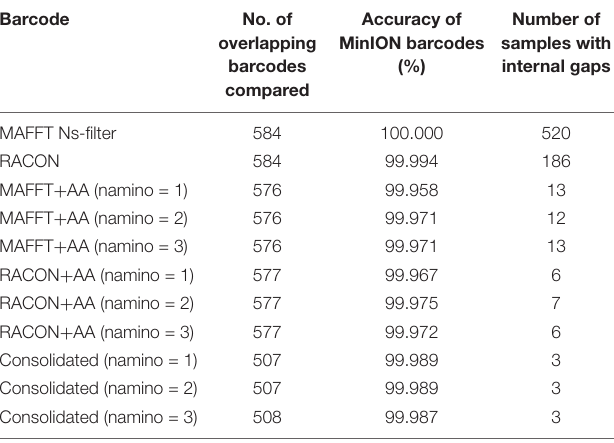
Again, the consolidated barcodes performed the best, with the same number of MOTUs obtained, and perfect match